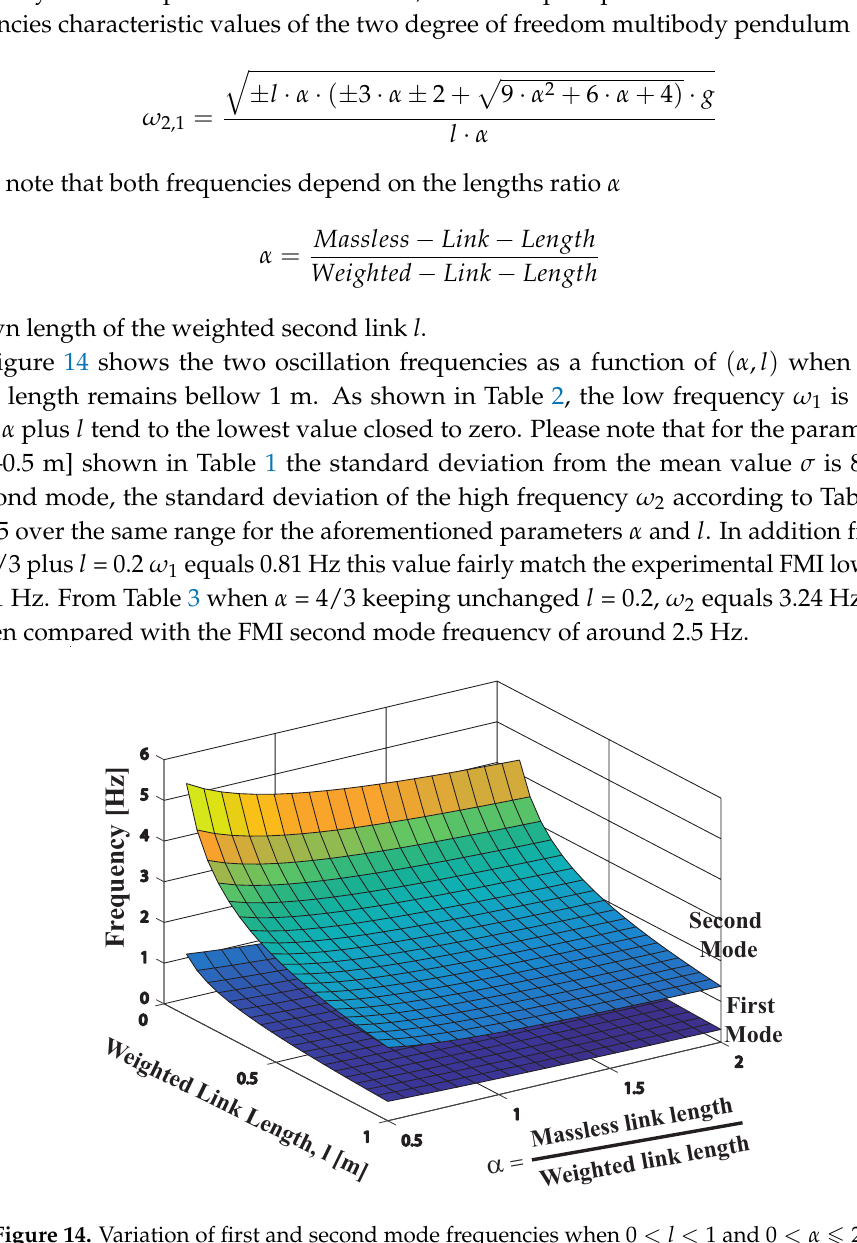
Figure 14. Variation of first and second mode frequencies when 0 < l < 1 and 0 < α (cid:54)